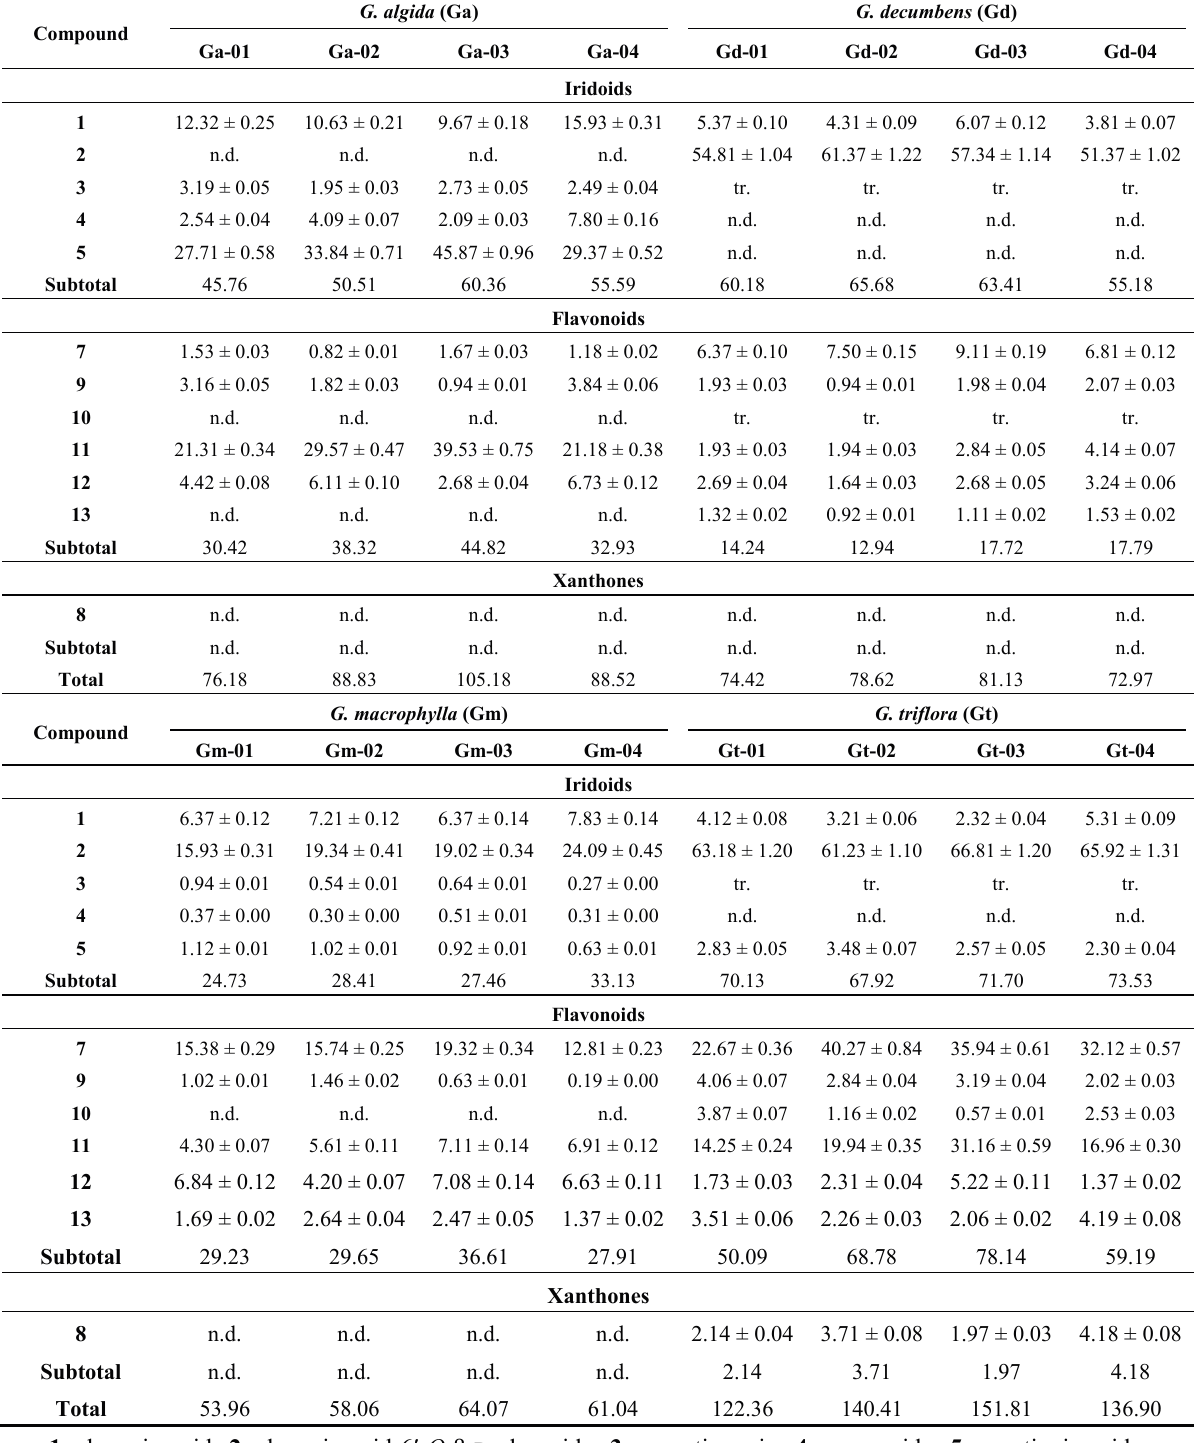
Table 3. Content of iridoids, flavonoids and mangiferin in four gentian herbs, mg/g (±SD) dry plant